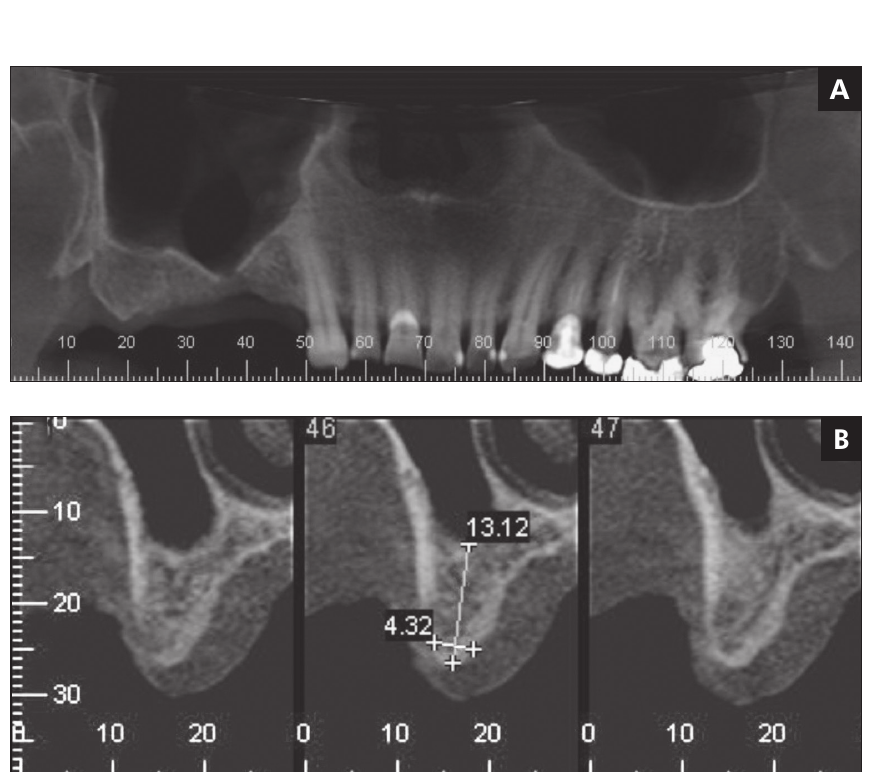
Figure 2 - A: CBCT PAN reconstruction; B: Bone measurement in the implant